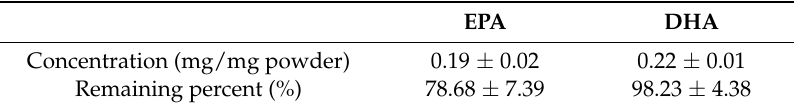
Table 6. The content of eicosapentaenic acid (EPA) and docosahexaenoic acid (DHA) of spray-dried omega-3 powder using γ -CD and hydrogenated lecithin with the optimal spray drying condition (n =